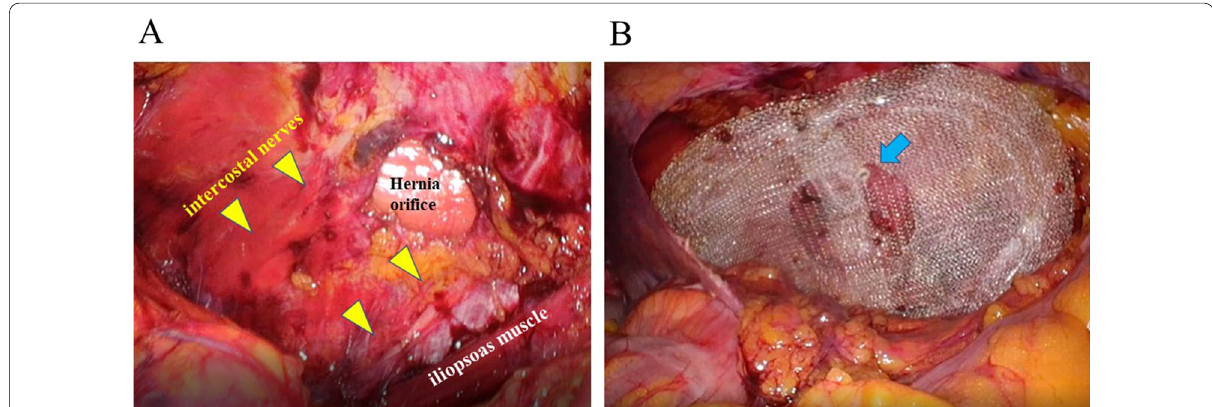
Fig. 3 Intraoperative view. A Hernia orifice. The hernia orifice, 3 2.5 cm in diameter, was identified between two intercostal nerves (yellow arrows). × B Placement of the self-expanding patch mesh. A modified Kugel patch was placed as its center (blue arrow) was positioned just above the hernia orifice and tacked to the abdominal wall at two points, 1 cm ventral and dorsal to the orifice taking care not to damage the